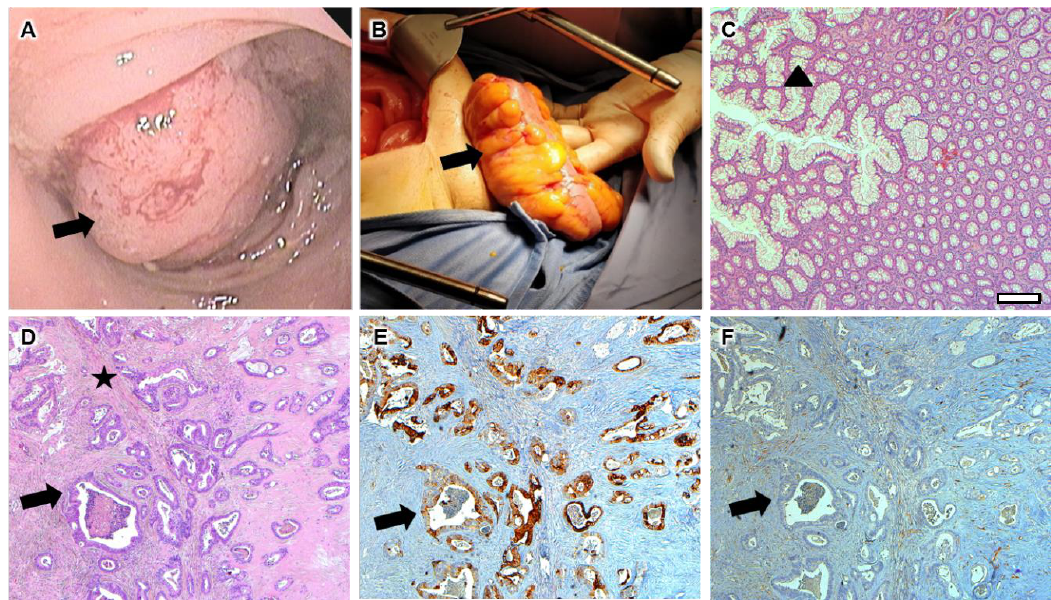
Figure 2. Diagnostic, interventional and immunohistochemistry workflow. ( a ) Colonoscopy view of the eroded vegetative mass (arrow) that underwent multiple biopsies; ( b ) colon excision (arrow) after both abdominal and inguinal surgical approach; ( c ) hematoxylin – eosin staining of normal sigmoid tissue (arrow-head) with numerous goblet cells; ( d – f ) moderately differentiated adenocarcinoma (arrow for hypercellular epithelium; star for fibrotic interstitium) stained for ( d ) hematoxylin – eosin, ( e ) CK20 and ( f ) CK7 (scale bar: 200 micrometers).